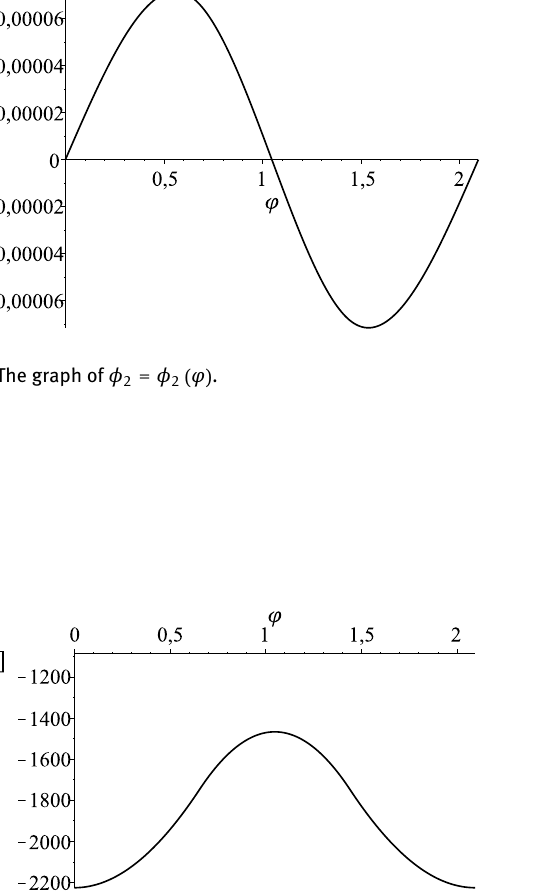
Figure 11: The case of β = α